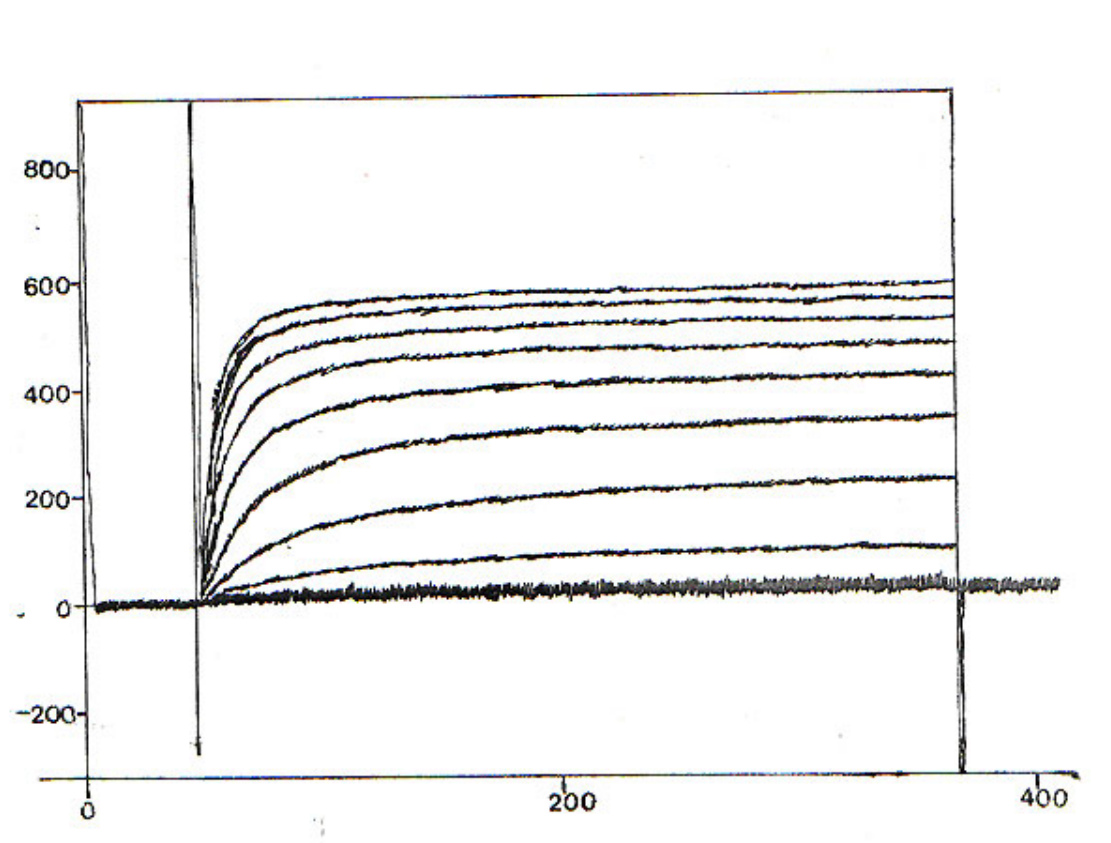
Figure 6b: The same oocyte after the addition of 20 nM Palamneus gravimanus toxin. After 30 min, the maximum current at +10 mV reduced to 523 nA.